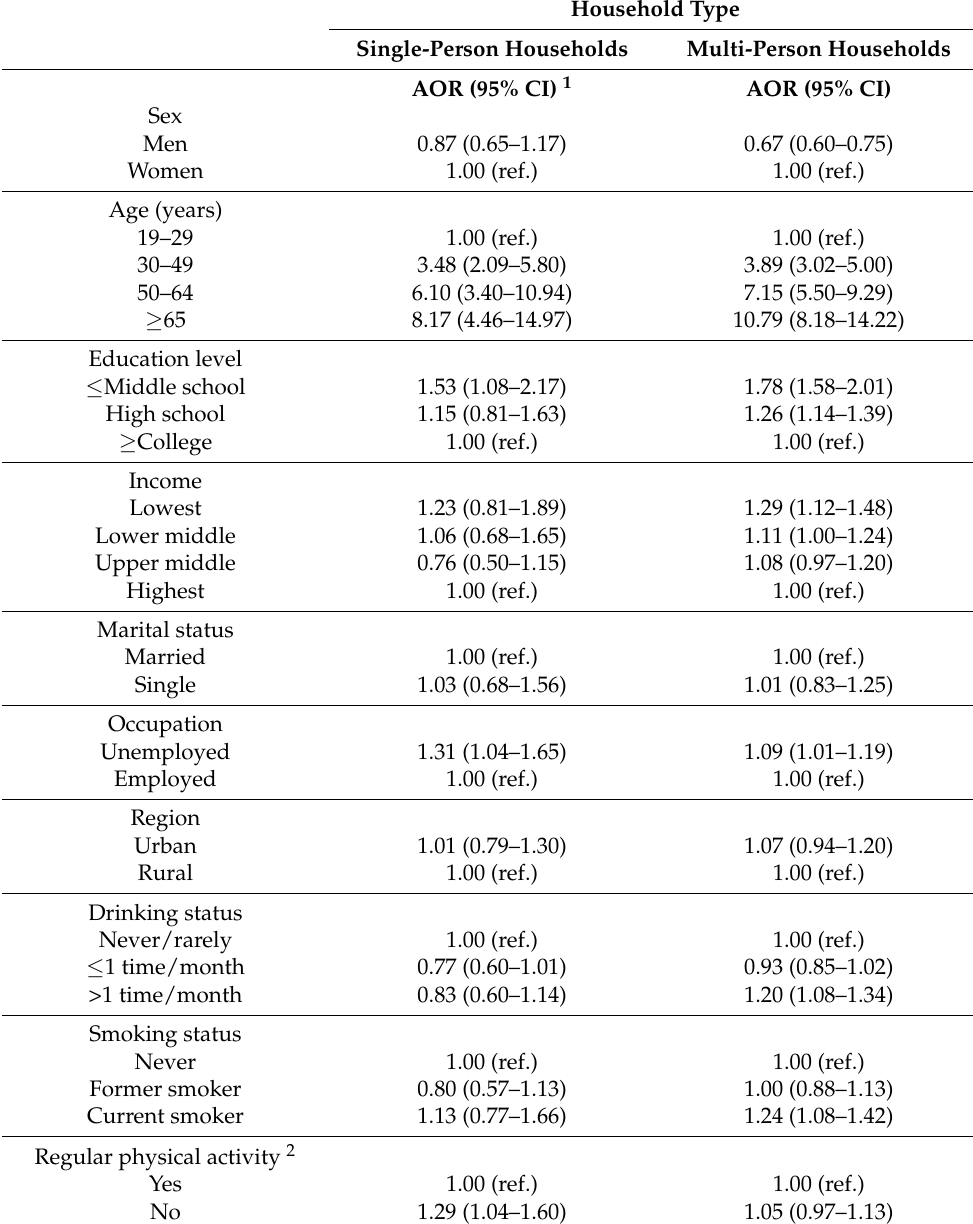
Table 5. Factors associated with metabolic syndrome among Korean adults according to household type, KNHANES